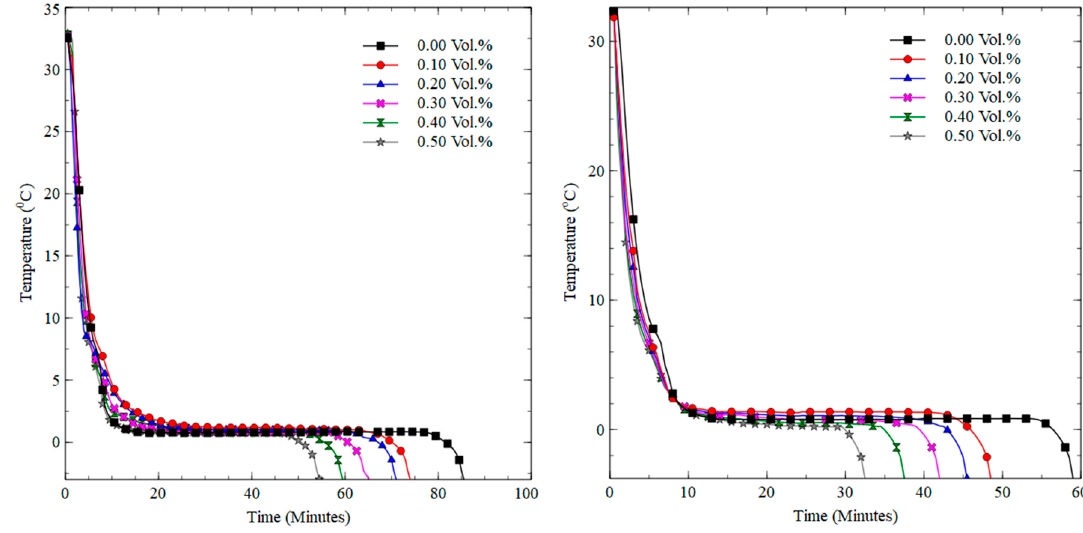
Figure 5. Freezing curves at from 32 ◦ C to − 3 ◦ C with a bath temperature of − 6 ◦ C and − 10 ◦ C. Similarly, at the bath temperature of − 10 ◦ C, the time taken to solidify the base fluid was 55.5 min, whereas for the 0.1%, 0.2%, 0.3%, 0.4%, and 0.5% vol. fractions of nanocomposites, the time taken was 46 min, 43.5 min, 40 min, 36 min, and 31 min, respectively. Thus, the addition of nanoparticles